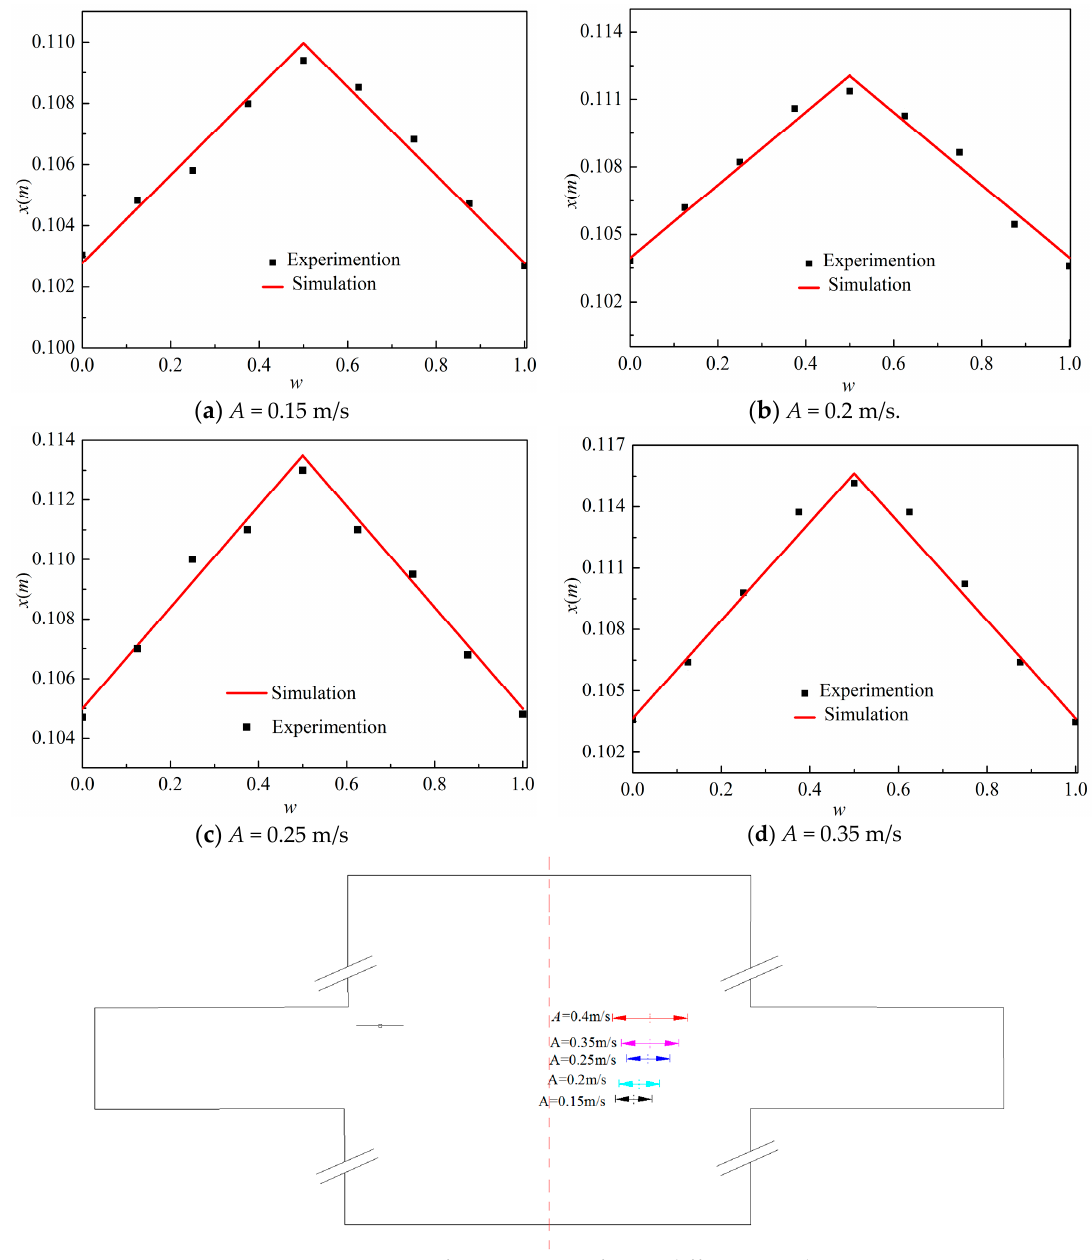
Figure 13. Effect of amplitude on the position of the impinging surface, as determined by PIV and CFD for sinusoidal inlet velocities at u m = 1.25 m/s, T = 0.4 s, L / D = 4 and ∆ ϕ = T /2 during one